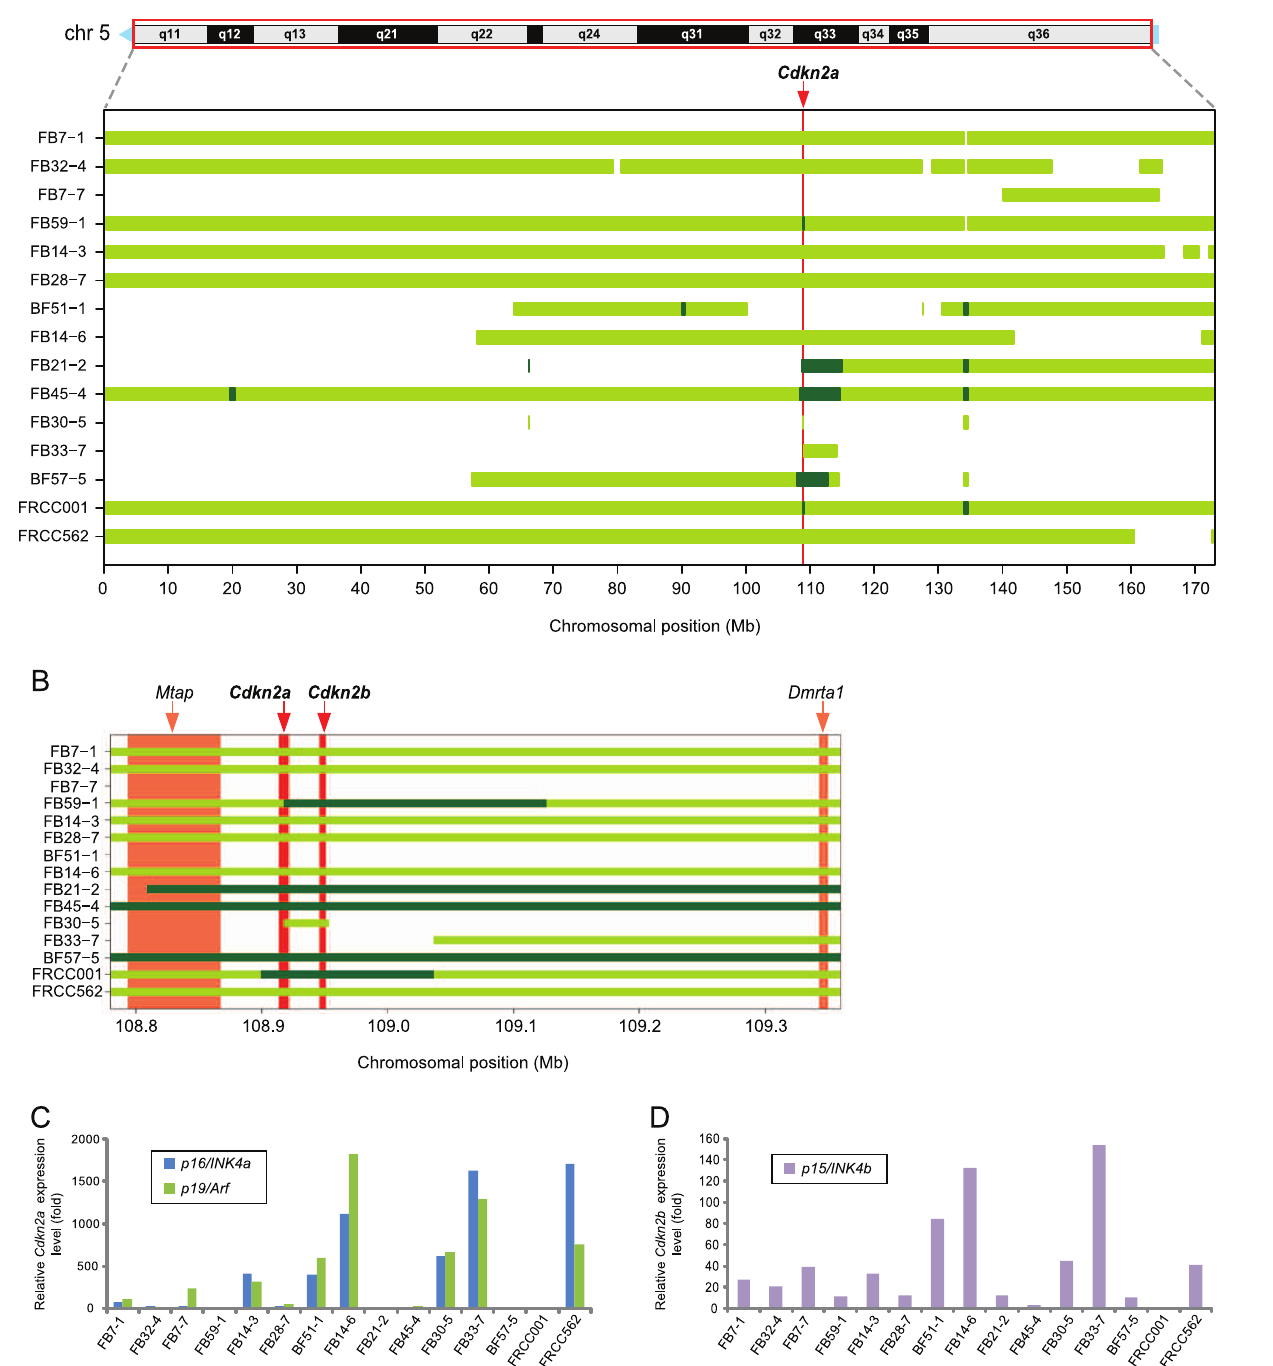
Figure 2. Frequent extensive chromosomal losses in rat chromosome 5, and homozygous deletions at the region including the Cdkn2a and Cdkn2b loci. (A) The bar chart represents the regions of chromosomal loss (green yellow) and homozygous deletion (dark green) along chromosome 5 for 13 RCC tumors and two RCC cell lines. The vertical red line on the background indicates the position of the Cdkn2a locus. (B) Magnified view of the bar chart centered on the Cdkn2a/2b loci. The genomic regions of all of the RefSeq genes included in the displayed range of the chromosome are depicted as vertical bars on the background. (C) Expression analysis of Cdkn2a ( p16 Ink4a and p19 Arf ) for 13 RCC tumors and two RCC cell lines, using real-time PCR with specific primer pairs for each different transcript. The values on the y -axis indicate relative mRNA expression level compared to an average of those in normal kidneys of three control rats. (D) Expression analysis of Cdkn2b ( p15 Ink4b ) for 13 RCC tumors and two RCC cell lines by real-time PCR. The values on the y -axis indicate relative mRNA expression level compared to an average of those in normal kidneys of three control rats.